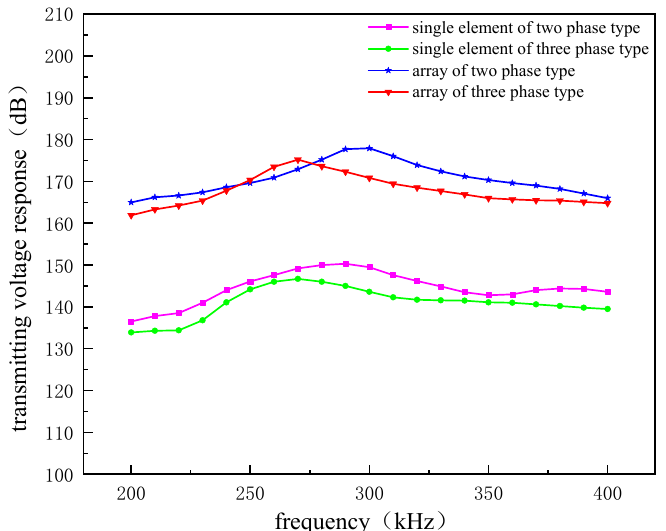
Figure 16. Transmitting voltage response curves of the two array transducers in single-element mode and full-array mode.